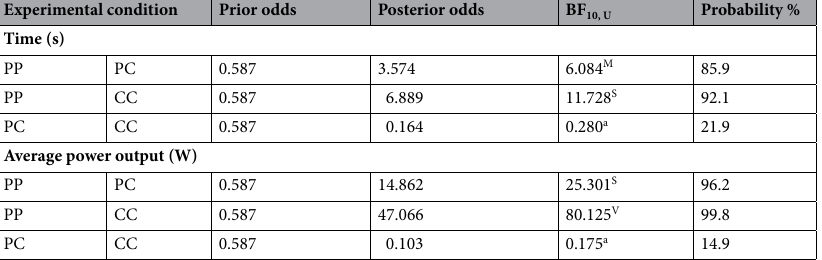
Table 3. Bayes factor analysis for time of TT-test execution and average power output among caffeine supplementation conditions. The posterior odds have been corrected for multiple testing by fixing to 0.5 the prior probability that the null hypothesis holds across all comparisons (Westfall, Johnson, & Utts, 1997). Individual comparisons are based on the default t test with a Cauchy (0, r = 1/sqrt(2)) prior. The “U” in the Bayes factor denotes that it is uncorrected (PP: Placebo–Placebo; PC: Placebo–Caffeine; CC: Caffeine– Caffeine). Letters indicate the outcome classified as: A = anecdotal; M = moderate; V = very strong; E =